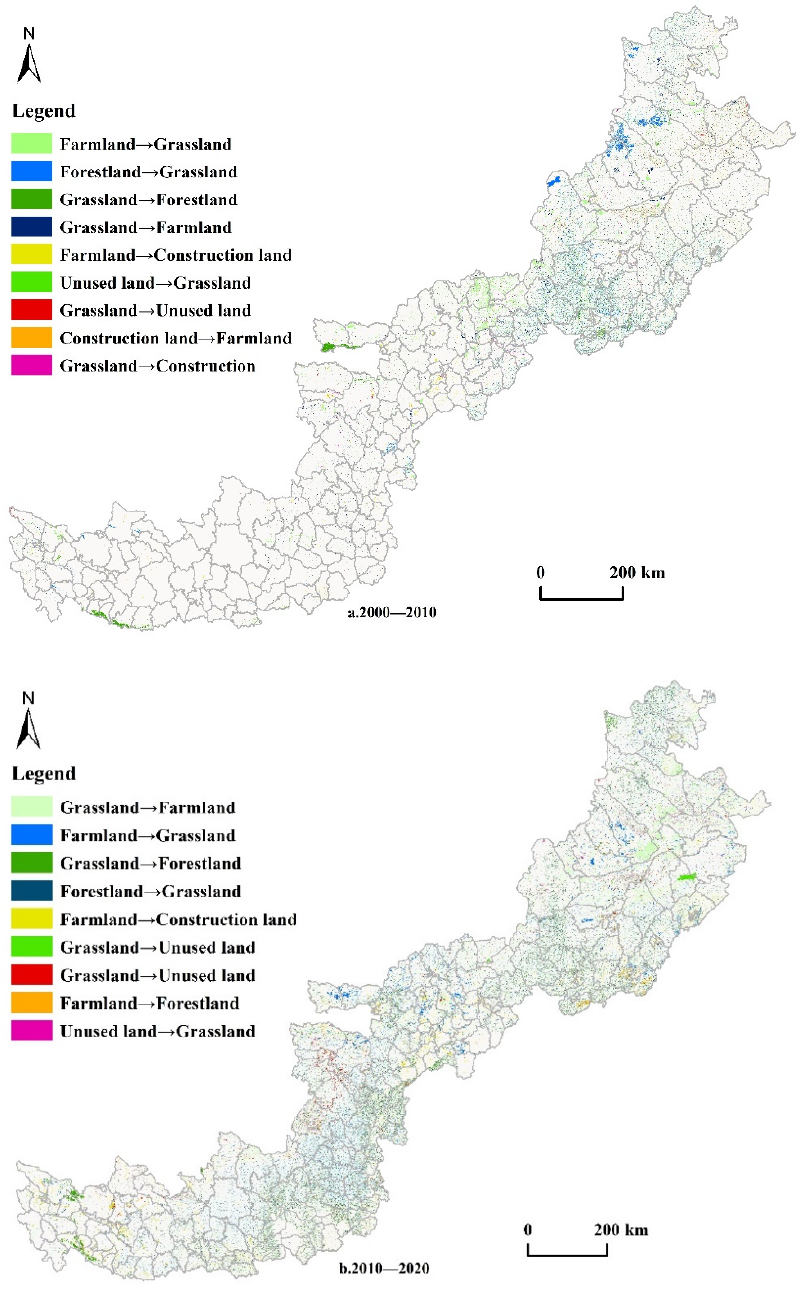
Figure 3. Main conversion types of land-use change in the AENC during 2000–2020. From 2010 to 2020, 30 types of land-use change occurred in the AENC, and the convert area was 111 532.13 km2, accounting for 15.95% of the total area, and the spatial distribution changed greatly (Figure 3b). As shown in Table 6, the main conversion types of land-use change were characterized by the mutual conversion among farmland, forestland, grass- land, and unused land. The first nine types represented 92.24% of the total area changed. The conversion from grassland to farmland accounted for 33,470.63 km 2 and 30.01% of the total area changed during 2010–2020, making it the most significant conversion type. It was mainly spread in the mountainous region of the northern and eastern margins in the junction among Inner Mongolia, Jilin, Hebei, and Liaoning as well as the low mountainous and hilly area of the Loess Plateau. In addition, the decreased grassland was turned to forestland, unused land, and construction land, accounting for 13.16%, 3.29%, and 2.98%